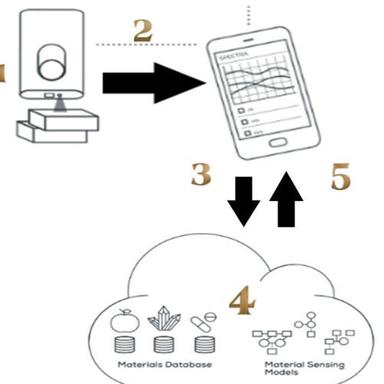
Schematic workflow of the material characterization process.